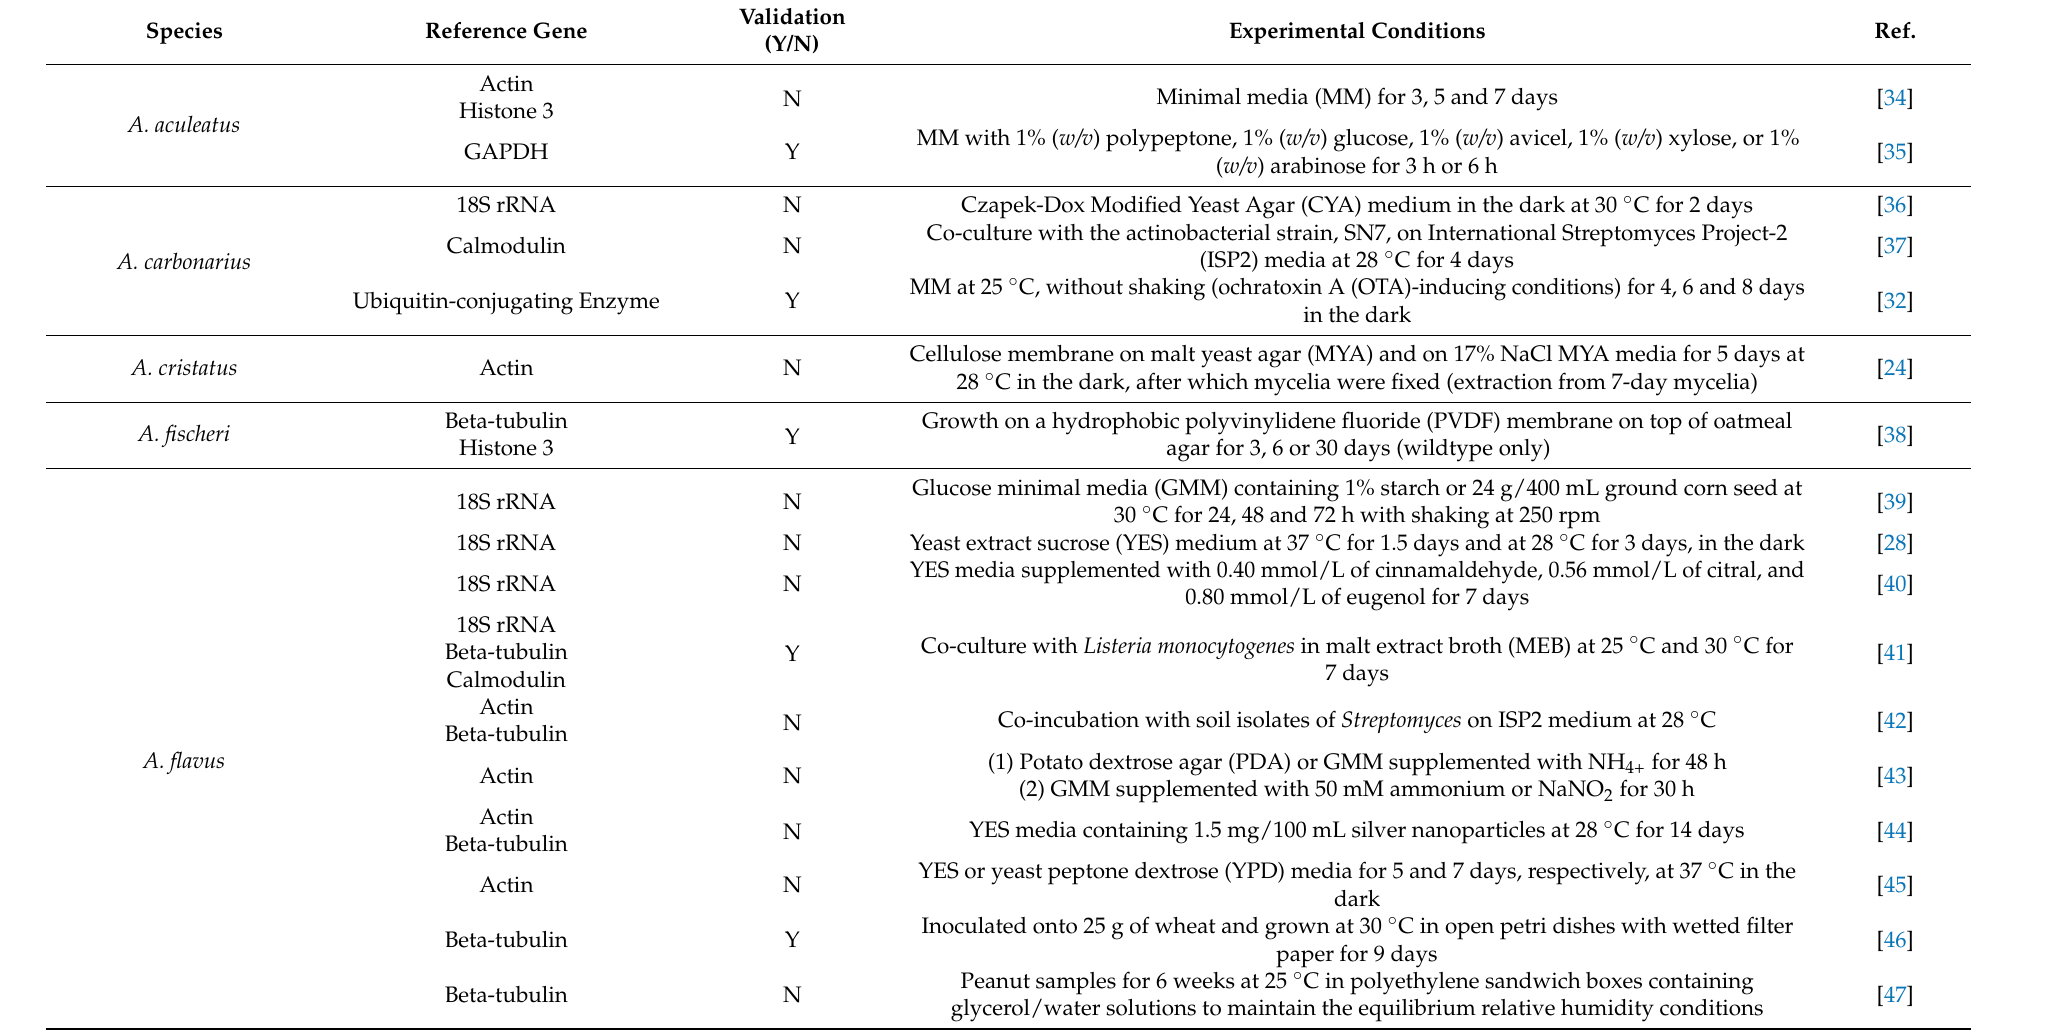
Table 1. Species, reference gene(s) and experimental conditions used in 90 RT-qPCR studies of Aspergillus